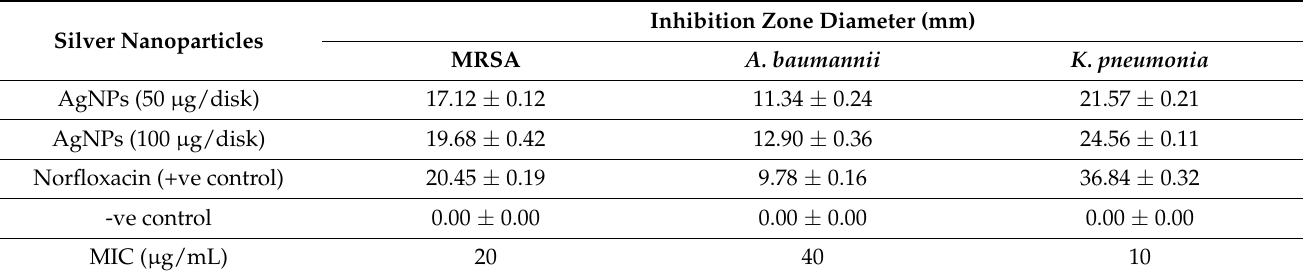
Table 3. Antibacterial efficiency of AgNPs against different bacterial